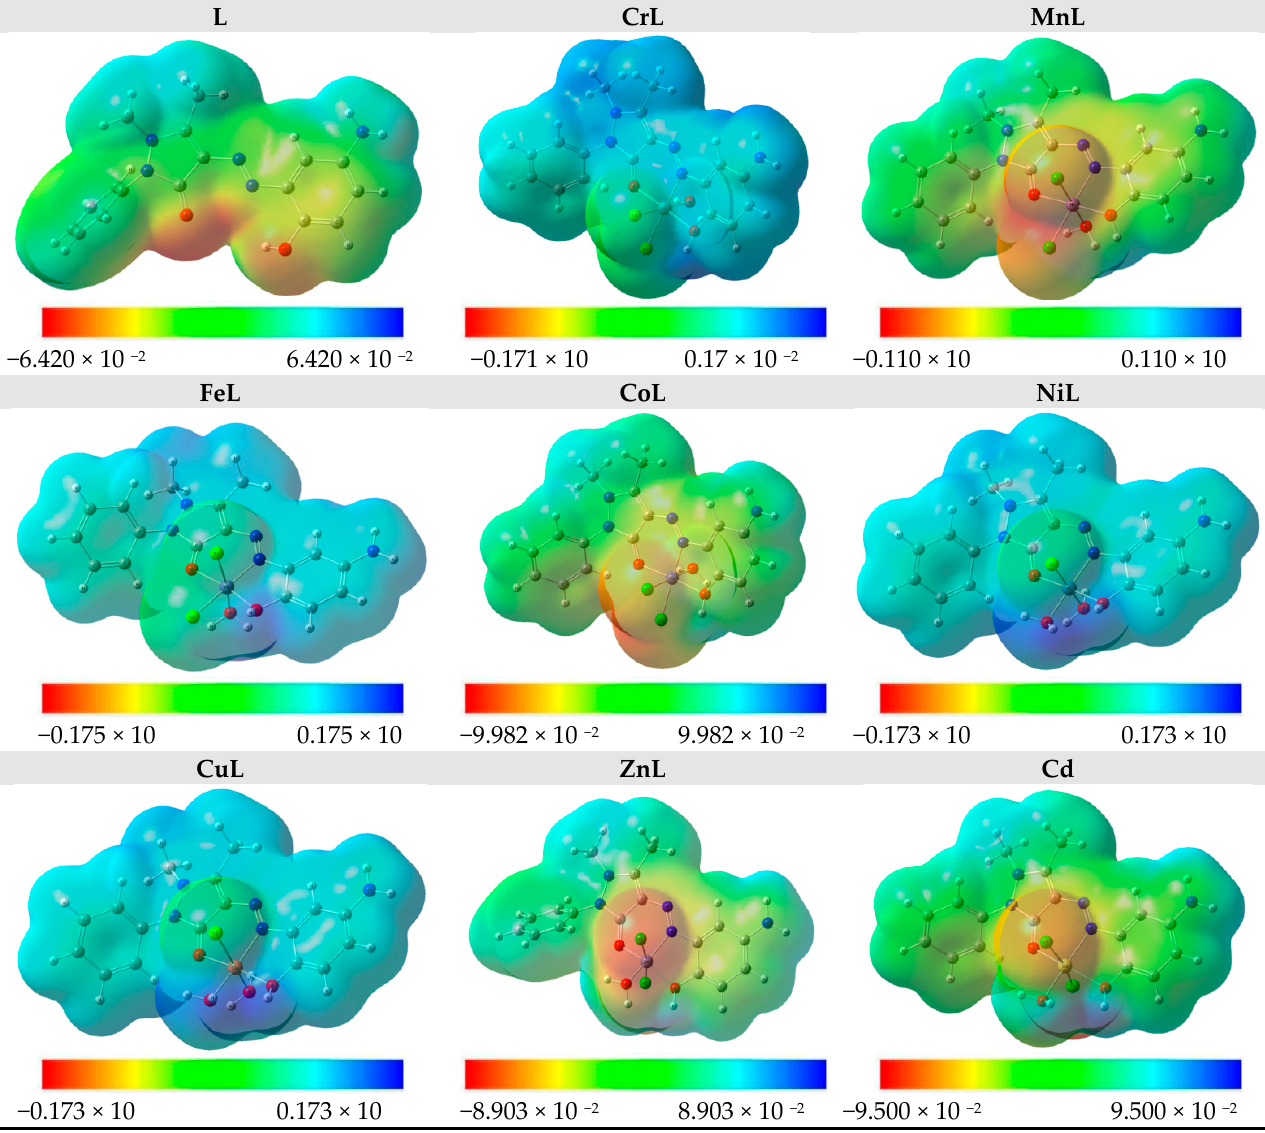
Figure 6. MEP of the studied